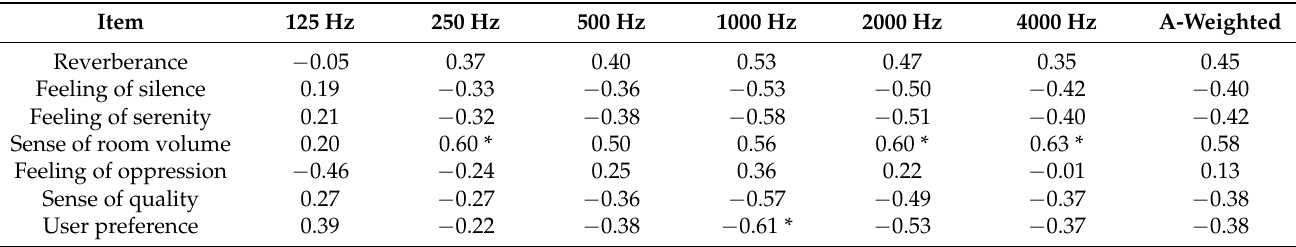
Table 12. Correlation coefficients between the background noise levels in nine rooms in modern Japanese dwellings and the psychological values of each evaluation